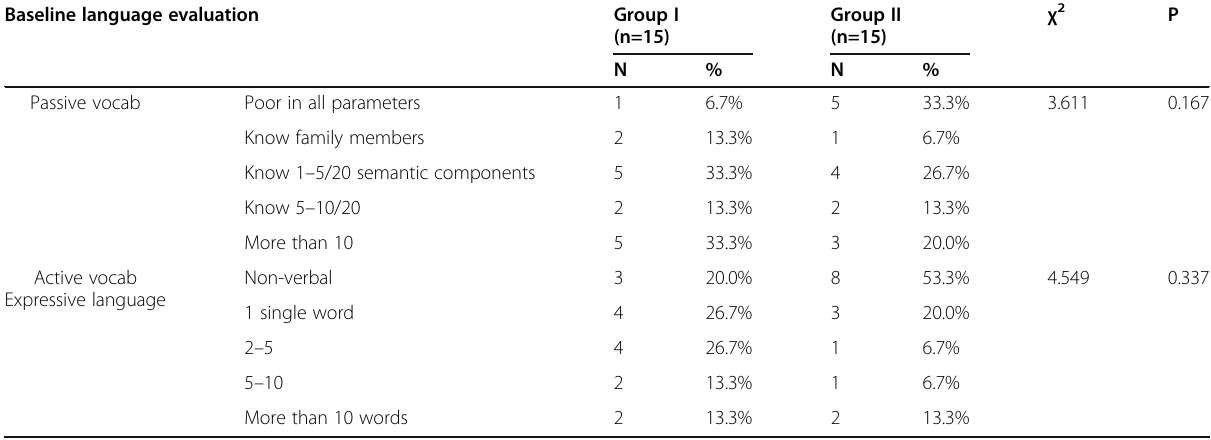
Table 3 Baseline language evaluation Baseline language